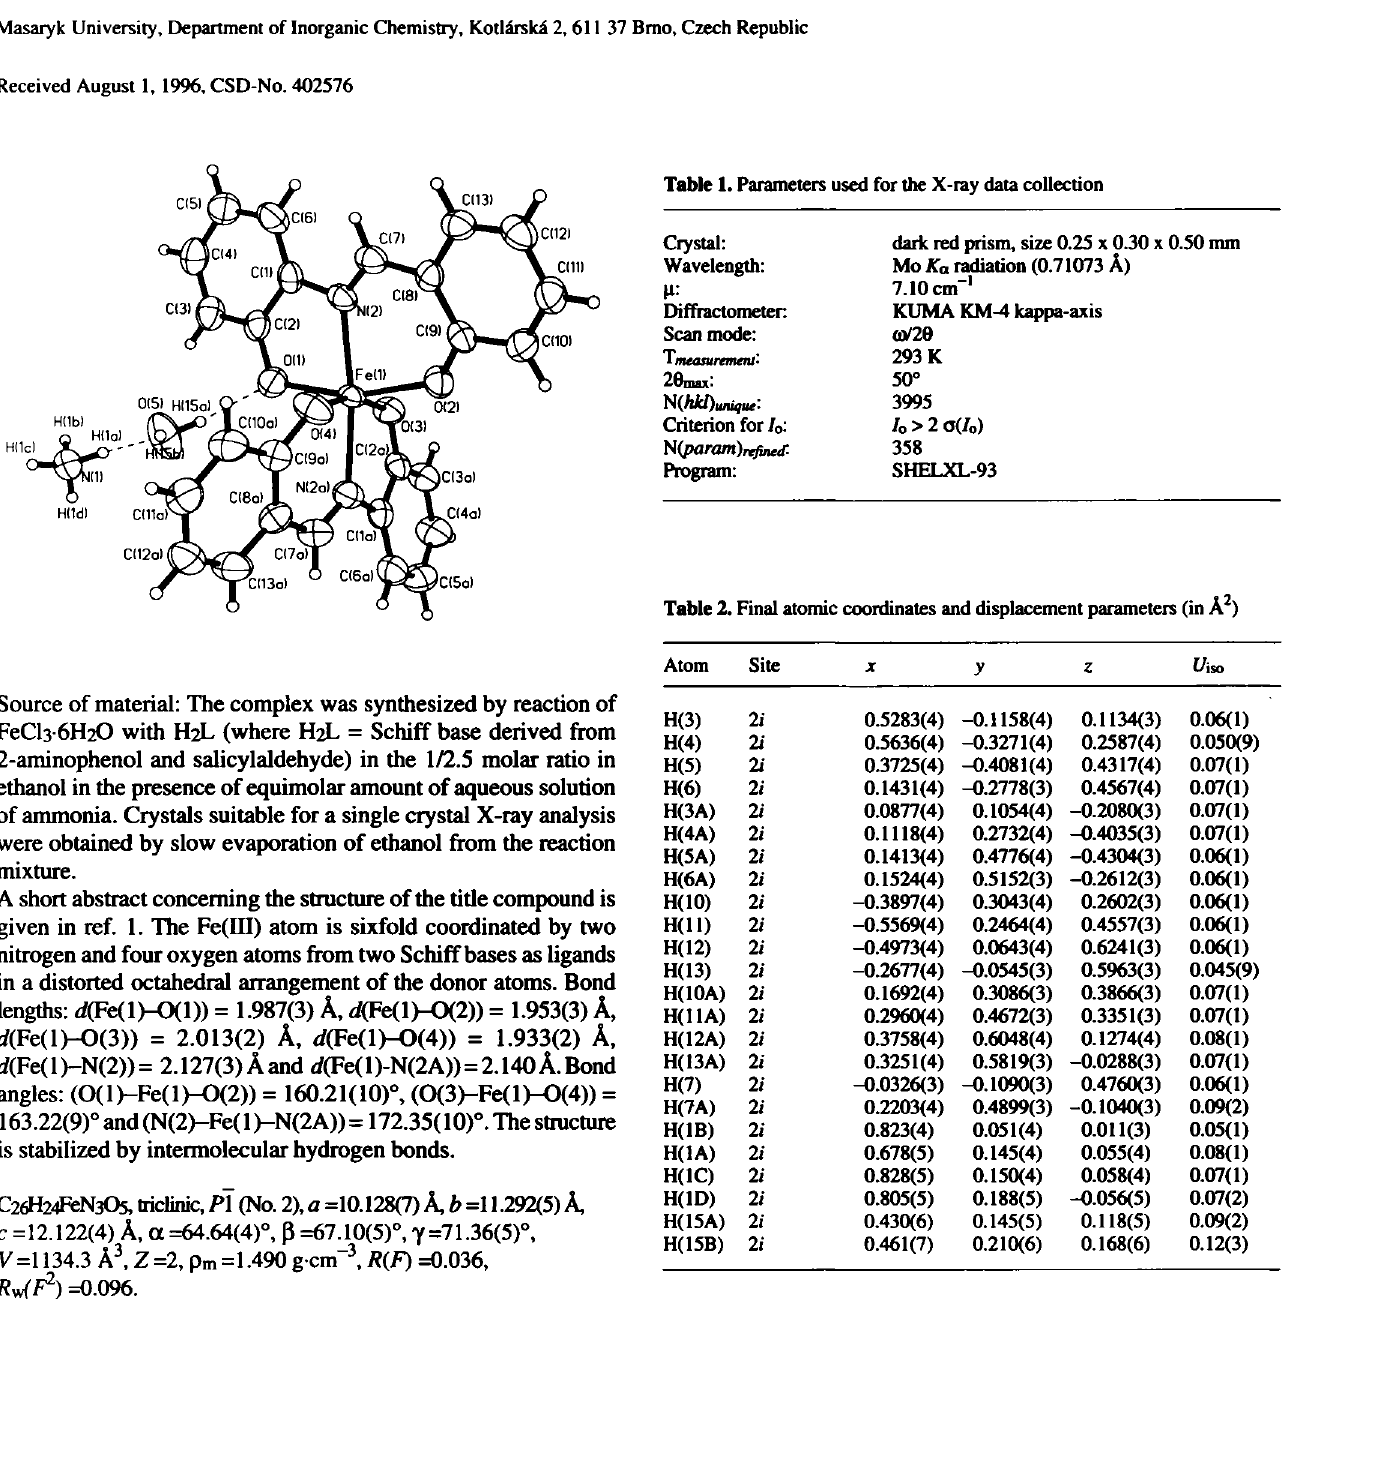
Table 1. Parameters used for the X-ray data collection Crystal: